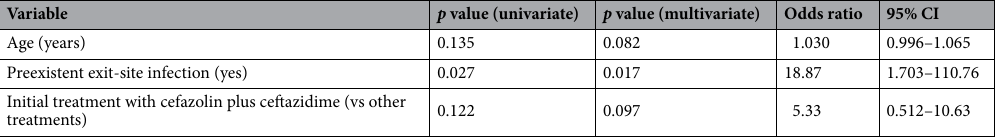
Table 5. Predictors of non-resolution of non-fermenting Gram-negative bacilli peritonitis in peritoneal dialysis—Logistic Regression Analysis (model